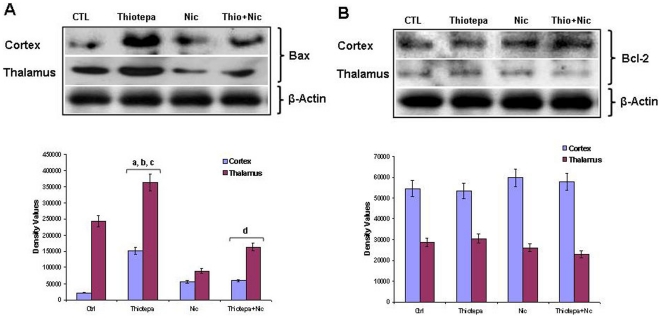
Co-treatment effect of nicotinamide (Nic) on thiotepa-induced expression of Bax and Bcl-2 protein levels.Representative Western blot analysis shows the expression levels of (A) Bax and (B) Bcl-2 protein in the cortex and thalamus of a 7-day-old rat. Treatment with (30 mg/kg) of thiotepa for 4 h increased Bax protein levels in the cortex and thalamus. Treatment with (1 mg/g) of nicotinamide for 4 h inhibited thiotepa-induced upregulation of Bax protein levels in the cortex and thalamus, as shown. The protein bands of the Western blot were quantified using Sigma gel software; their differences are represented in the graph. Actin was used as a protein loading control. Density values, expressed as mean ± SEM (n = 5–6 animals/group), of Bcl-2 and Bax proteins are presented. The density values on the Y-axis are expressed as arbitrary units (AU). Statistical difference was determined using one-way analysis of variance (ANOVA) followed by Student's t-test. (aSignificantly different from CTL, [cortex P<0.001 and thalamus P<0.05]; bSignificantly different from Nicotinamide, [cortex P<0.01 and thalamus P<0.001]; cSignificantly different from Thiotepa + Nicotinamide, [cortex P<0.01 and thalamus P<0.05]; dSignificantly different from Thiotepa, [cortex P<0.01 and thalamus P<0.05]).